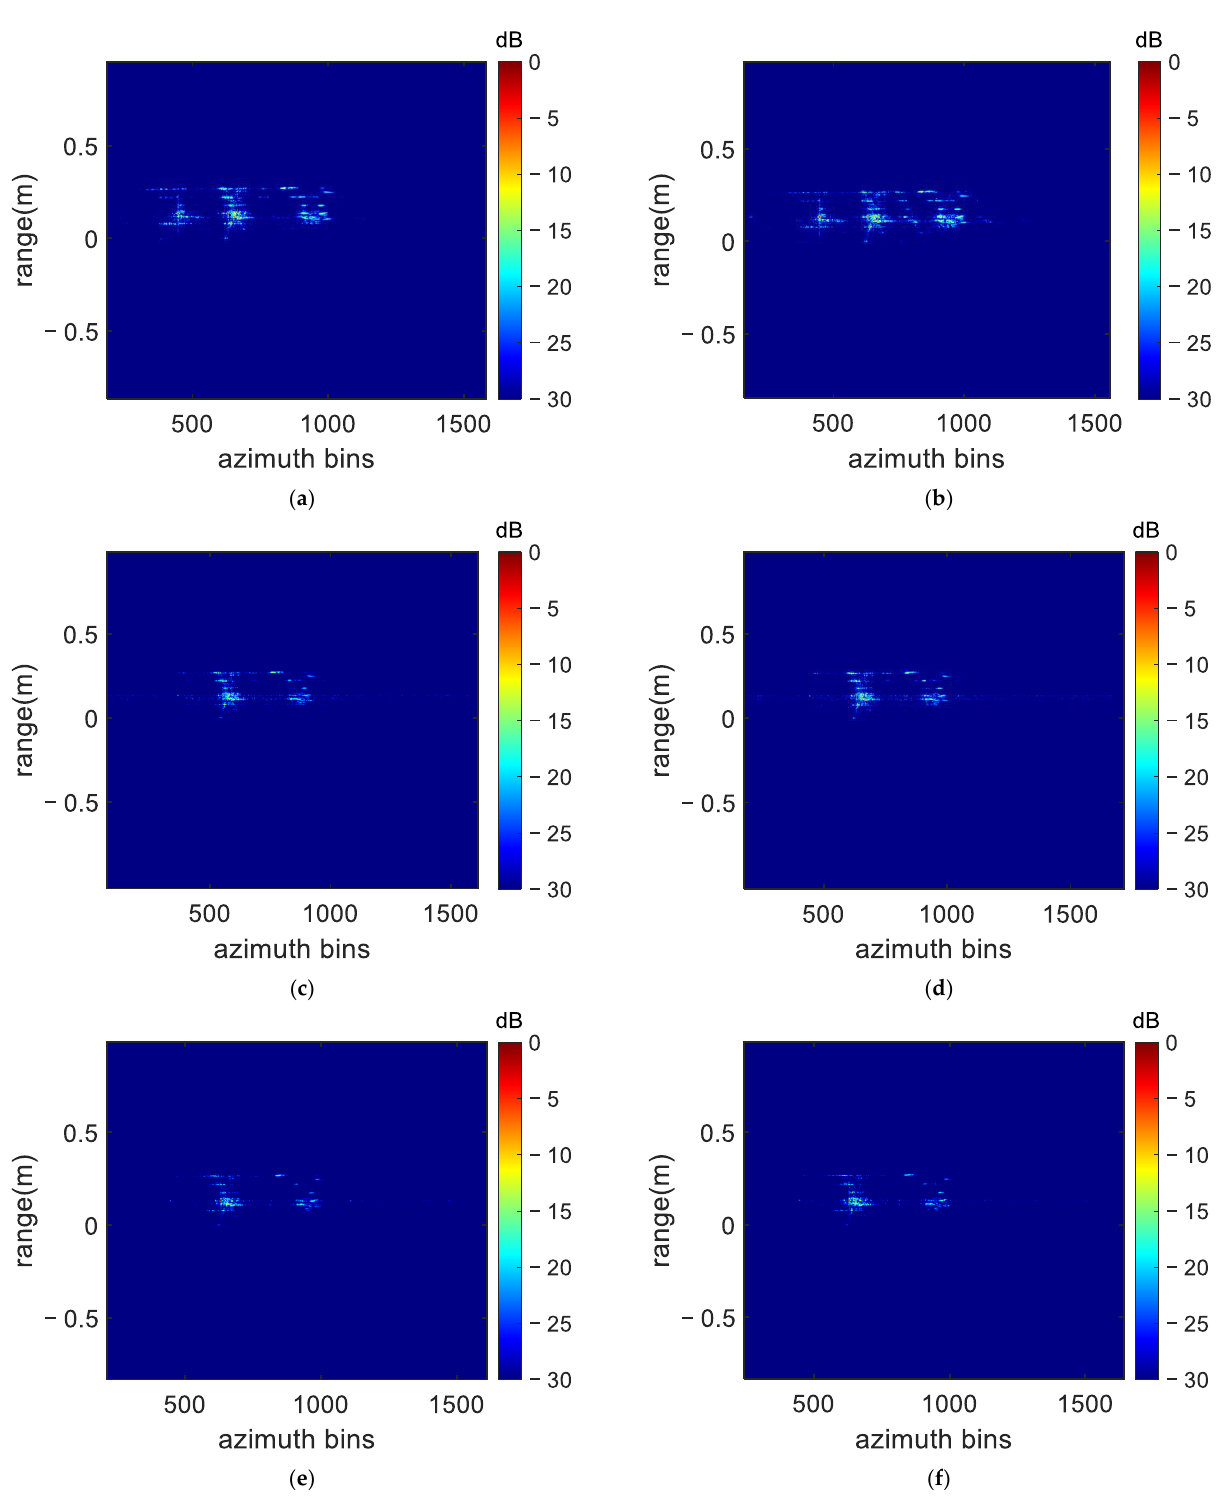
Figure 12. The imaging results of different methods in different SNR conditions: ( a ) FP-MEA (−5 dB); ( b ) FP-MEA (−10 dB); ( c ) N-MEA (−5 dB); ( d ) N-MEA (−10 dB); ( e ) DN-MEA (−5 dB); ( f ) DN-MEA (−10 dB).